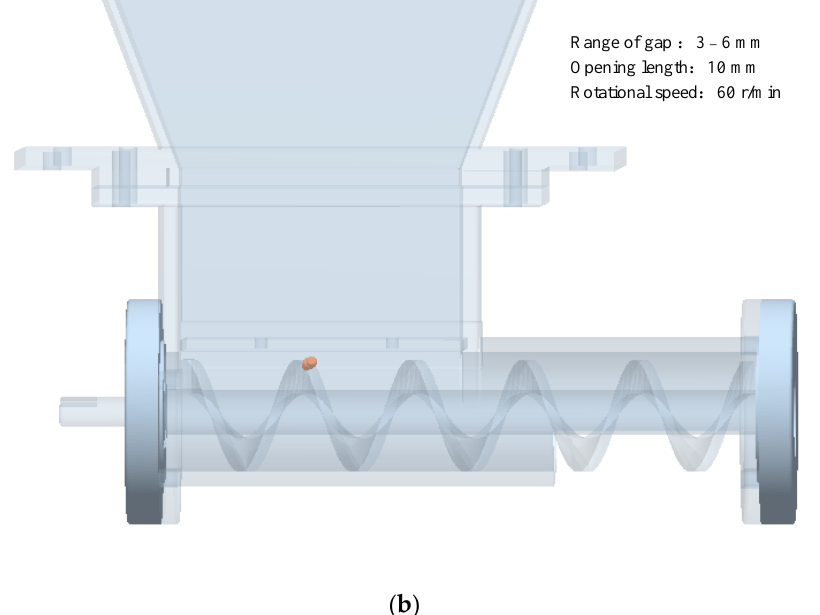
Figure 2. Illustration of mechanical parameter optimization by EDEM: ( a ) Schematic diagram of opening-length optimization using EDEM; ( b ) schematic diagram of gap determination through EDEM.